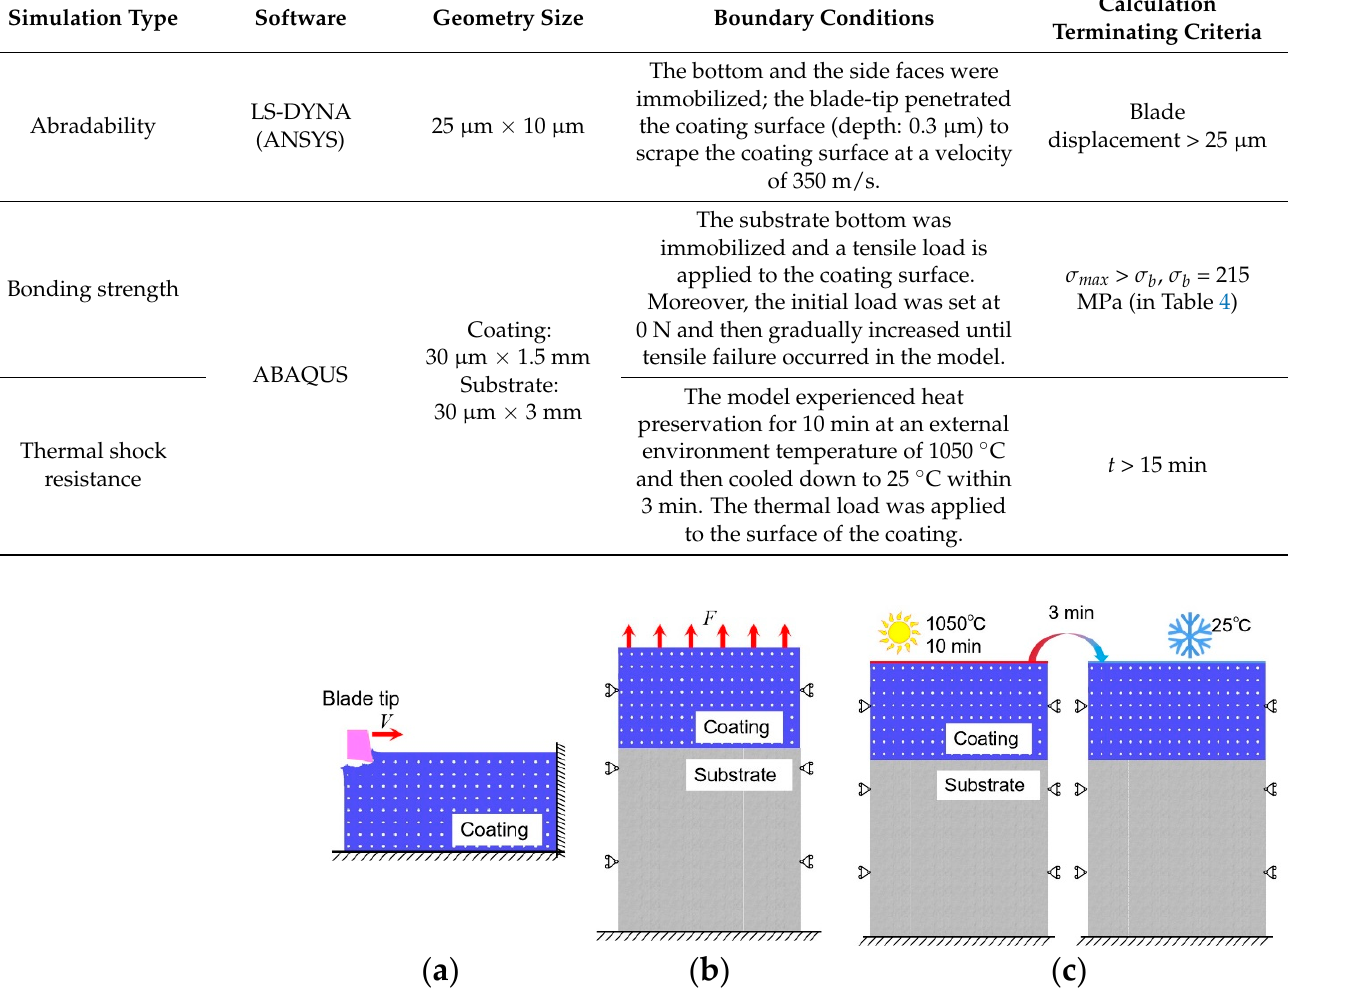
Figure 5. Schematic diagram of the simulation processes: ( a ) abradability and scraping process simulation, ( b ) bonding strength and tensile test simulation, ( c ) thermal shock resistance and thermal cycling process simulation. Table 3. Description of the FEM simulation models.